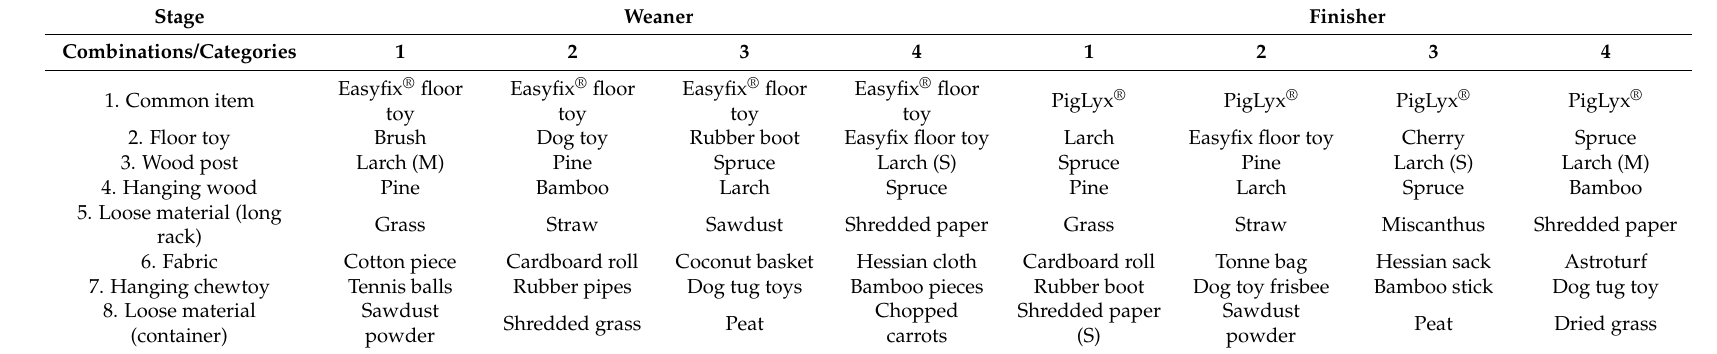
Table 2. The enrichment item combinations from different categories in randomised